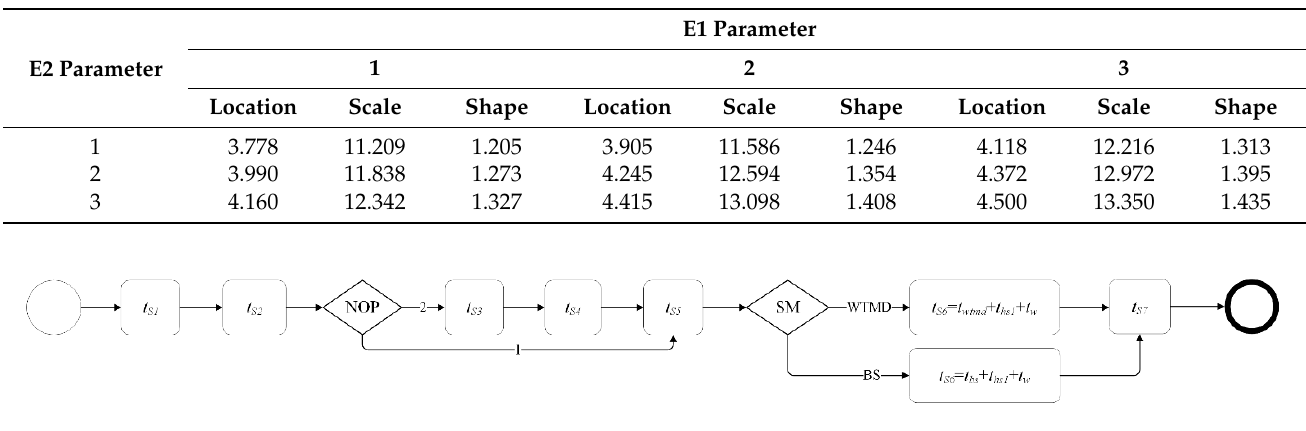
Figure 4. Simplified algorithm for simulating passenger flow through a security lane. Table 3. Distributions describing the other variables in the simulation model.